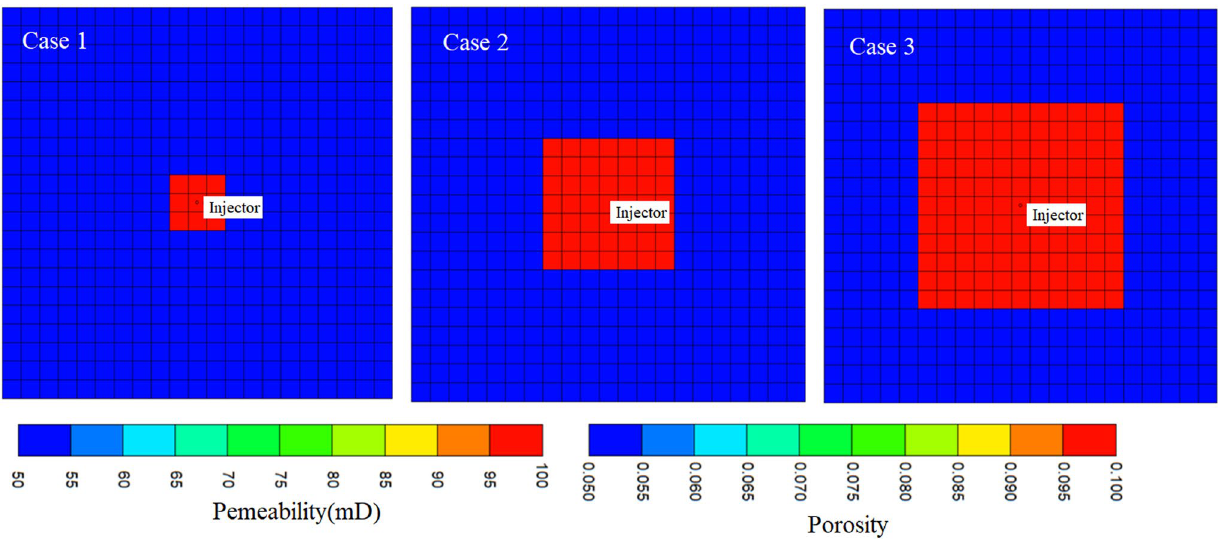
Fig. 4 Map view of three additional cases with expanding size of higher porosity and permeability zones with case 1 having smallest zone and case 3 having largest zone